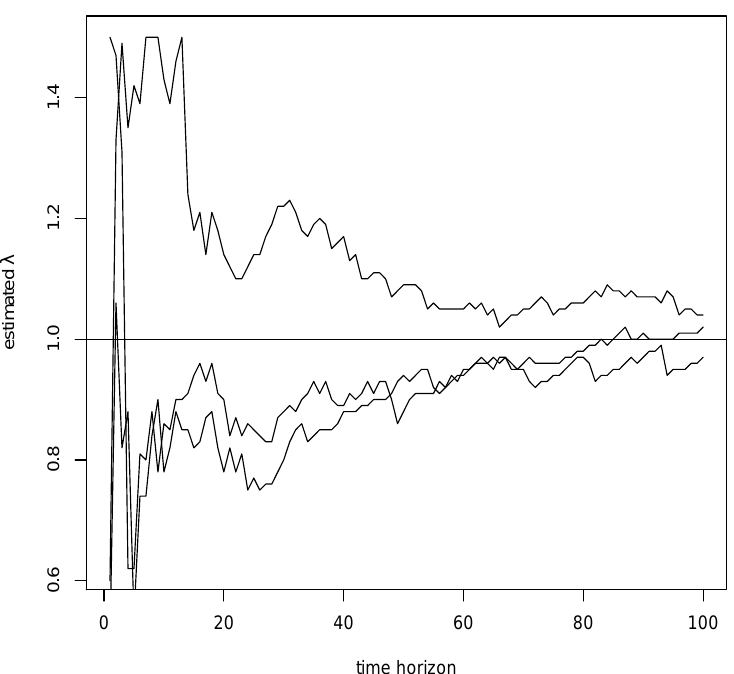
Figure 7. The convergence of ˆ λ for three sample solutions from Example 1 with H = 0.75 and X 0 = ( 10,10,10,10 ) ; the horizontal line shows the true value of the estimated parameter λ = 1.